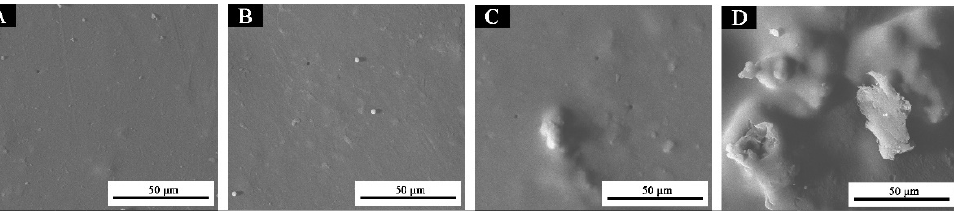
Figure 4. Morphology of the coatings with different content of the microcapsules: ( A ) 0%, ( B ) 1.0%, ( C ) 7.0%, ( D ) 13.0%.